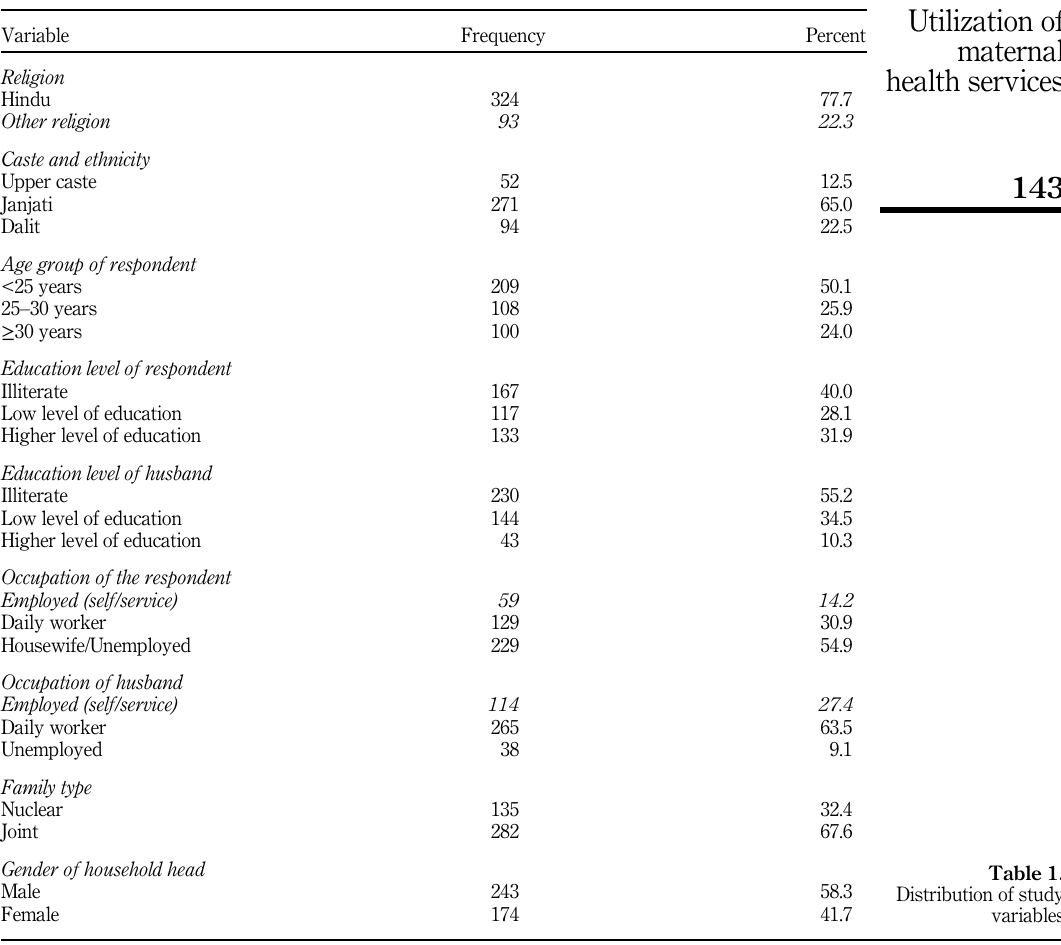
Table 1. Distribution of